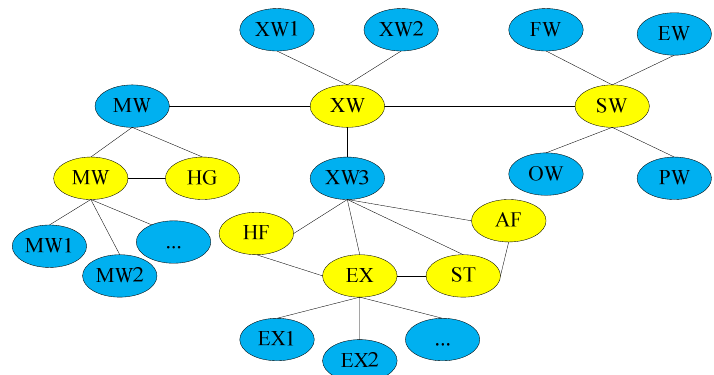
Figure 6. Partial topology model of the studied plant.